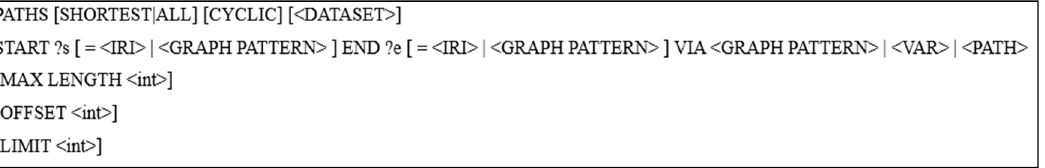
Figure 2. The path query syntax provided in the Stardog RDF database.